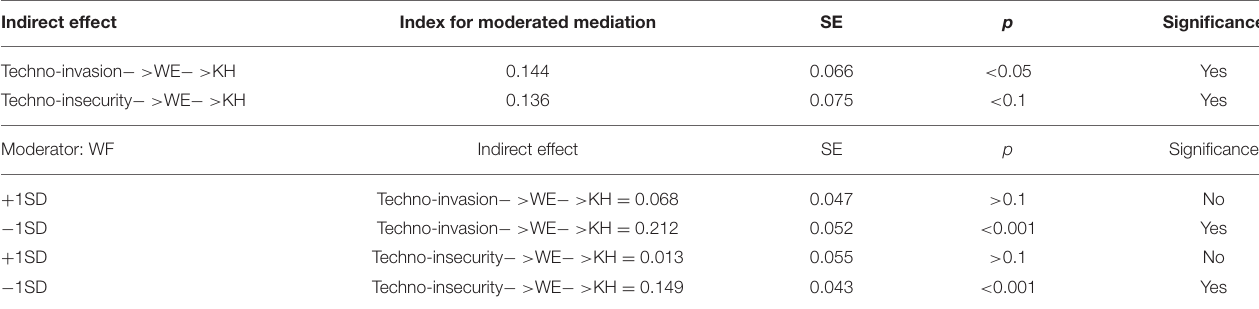
TABLE 9 | Moderated mediation test ( N =